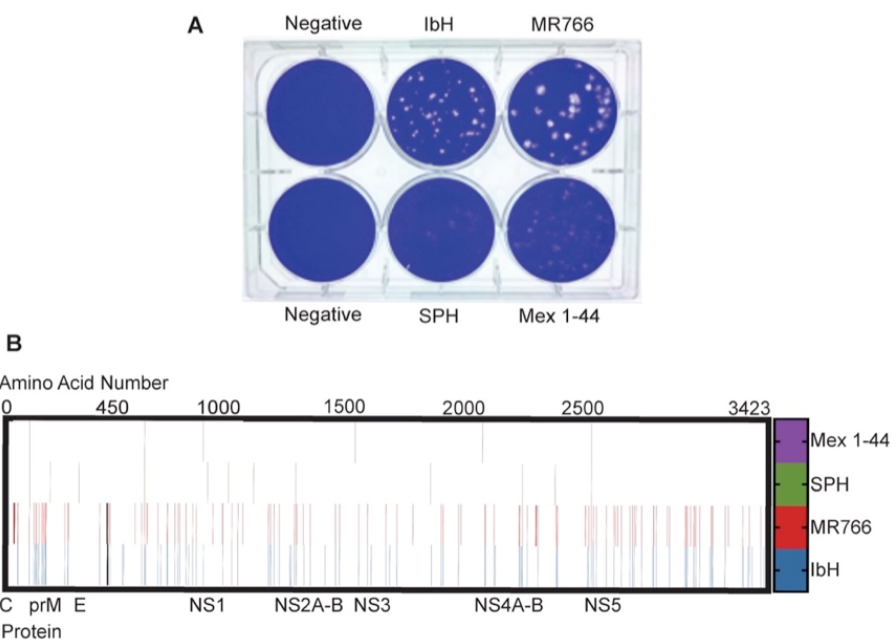
Figure 1. Genetic and phenotypic differences of Zika virus (ZIKV) lineages: ( A ) Plaque morphologies of the ZIKV isolates used in this study when stained at 4 days post-infection (dpi). Vero cells were infected with 100 plaque forming units (PFU) of each isolate; ( B ) Changes from the ZIKV consensus sequence across the translated ZIKV genome. Each line represents an amino acid change from the standard consensus sequence of ZIKV (PRVABC59-Genbank accession number KX087101.3). Black lines represent the E protein glycosylation site deletions in ZIKV AF